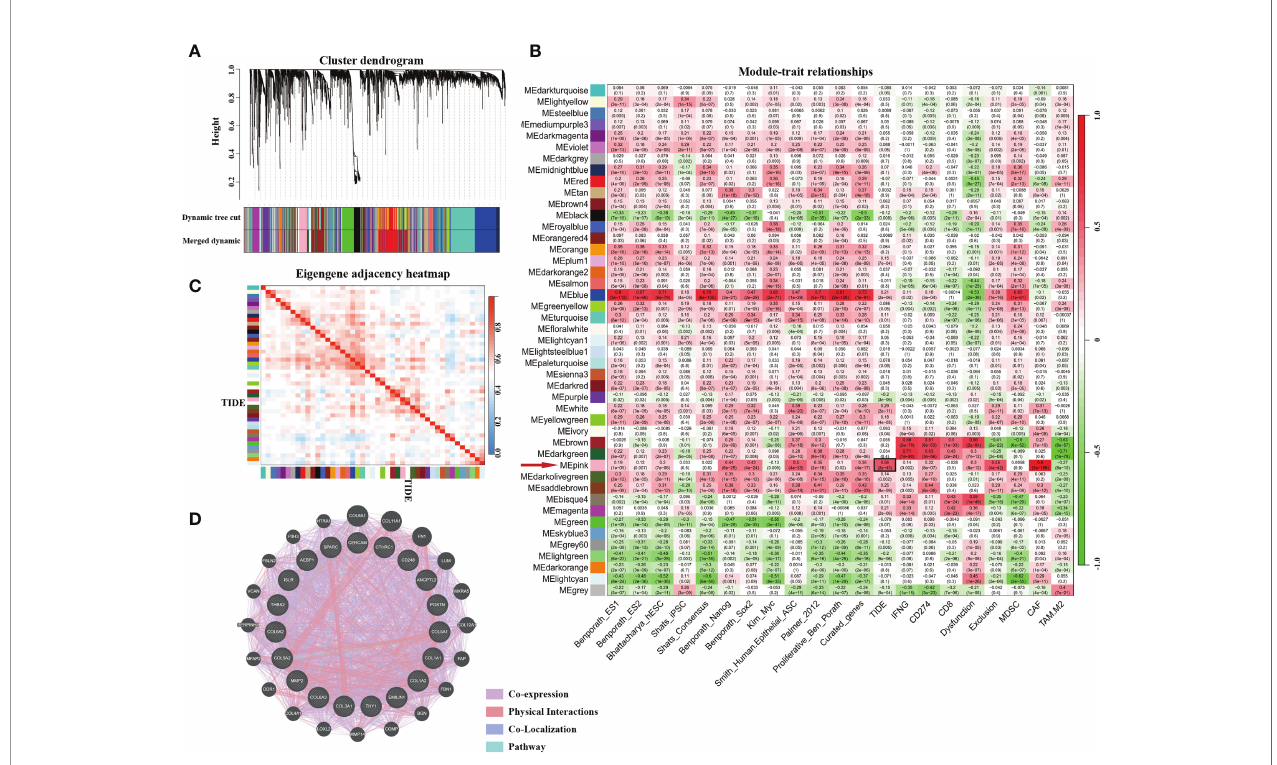
FIGURE 2 | The genes enrichment and module identi fi cation. (A) Hierarchical clustering dendrogram of co-expressed genes in LUAD patients. A total of 45 modules were identi fi ed, and each colored row stands for a module with a cluster of highly connected genes. (B) Correlation coef fi cient between consensus module eigengenes and TIDE score, cancer stemness, or other immune-related characteristics. (C) Heatmap plot of the adjacent modules. (D) Protein – protein interactions of top 20 hub genes. The strength of the relationship is associated with the thickness of the colorful